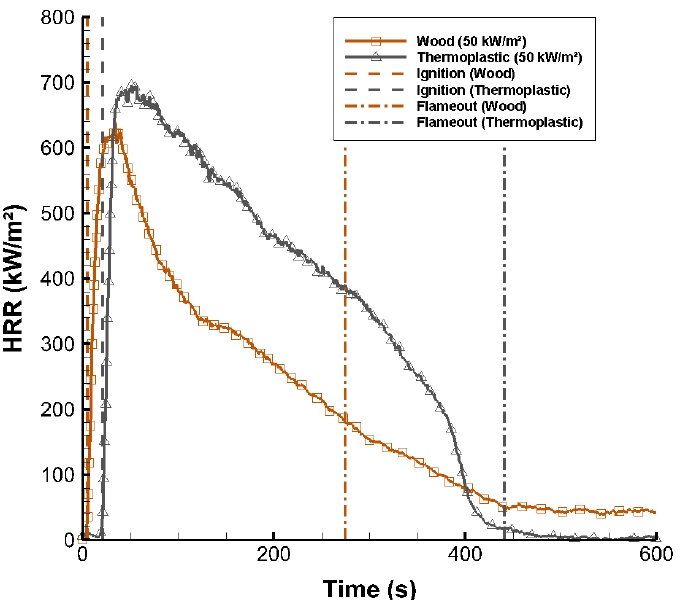
Figure 4. Heat Release Rate (HRR) as a function of time for an imposed heat flux of 50 kW/m 2 for wood ( □ ) and thermoplastic ( △ ) samples.